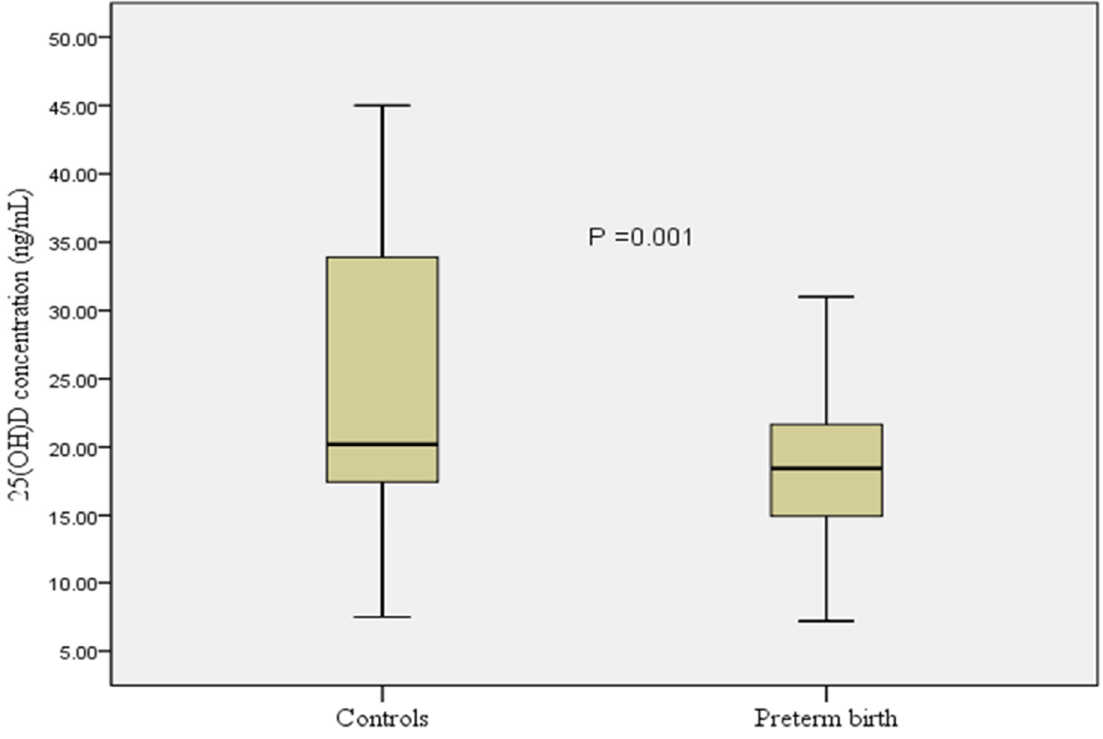
Figure 1. Comparing serum 25(OH)D concentration between women with preterm birth and the controls.